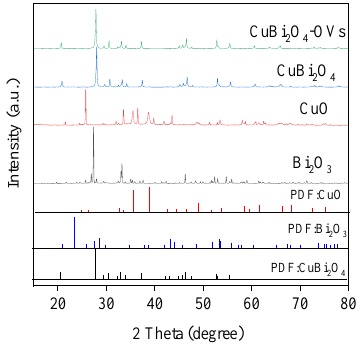
Figure 3. X-ray diffraction (XRD) patterns of as-prepared catalysts.